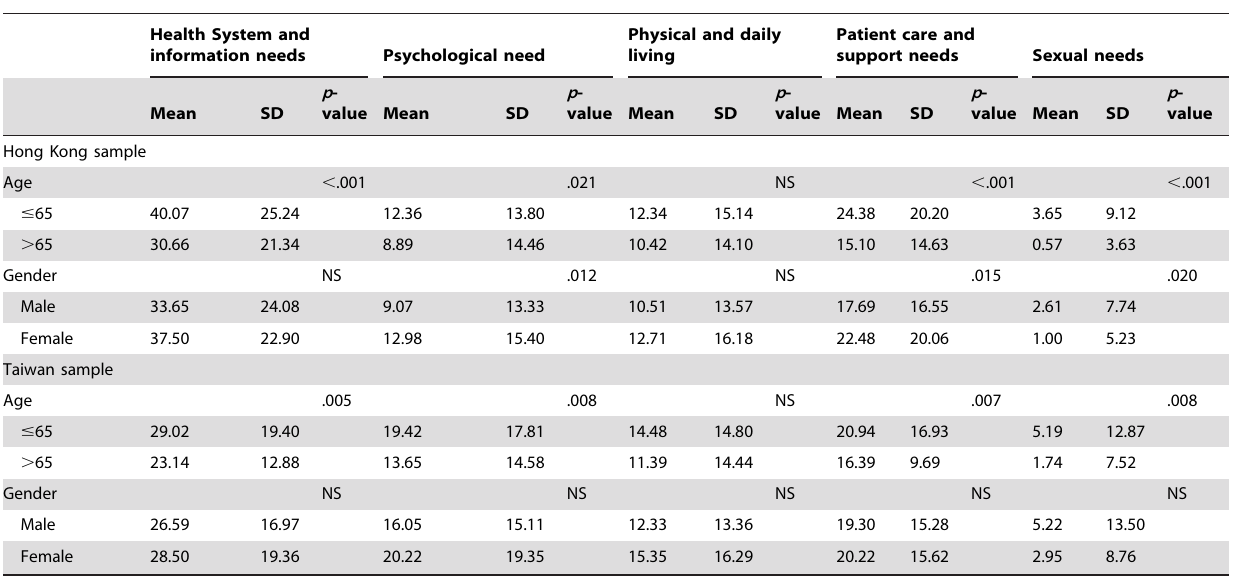
Table 6. Known group differences by SCNS-SF33-C 3-factor model